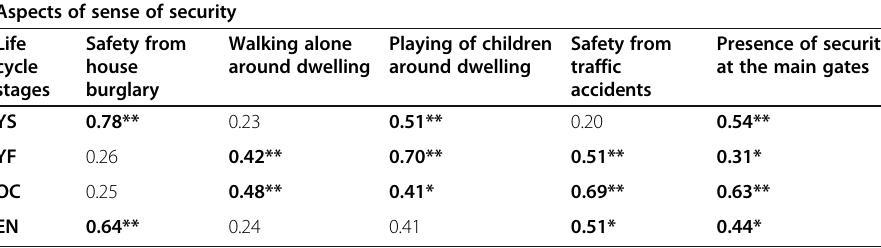
Table 9 Correlations between sense of security and its different aspects Aspects of sense of security